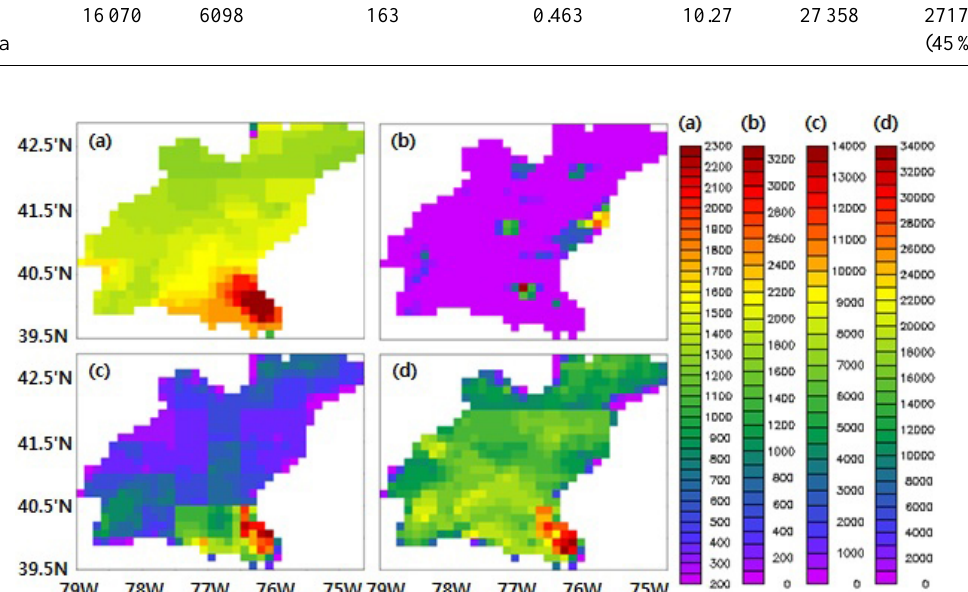
Figure 4. Spatial distribution maps of the applied 20year (1986-2005) average anthropogenic N sources: atmospheric deposition (kgkm − 2 year − 1 ) (a) , combined sewer overflow (kgkm − 2 year − 1 ) (b) , and fertilizer, manure, and legume applications (kgkm − 2 year − 1 ) (c) , and (kgcroplandkm − 2 year − 1 ) (d)